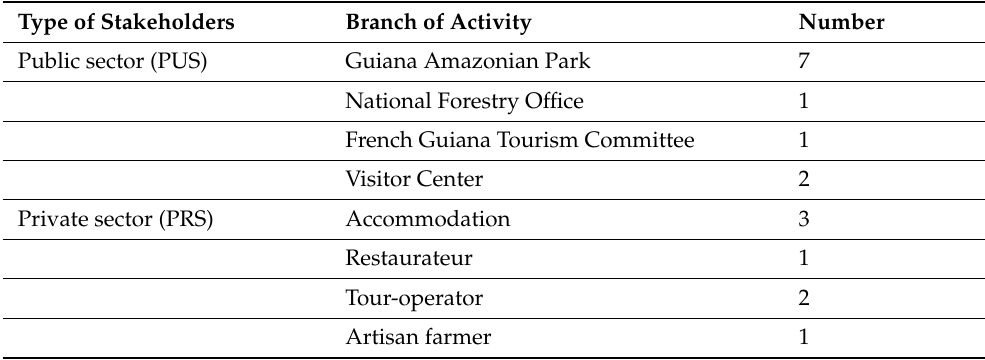
Table 1. List of interviews